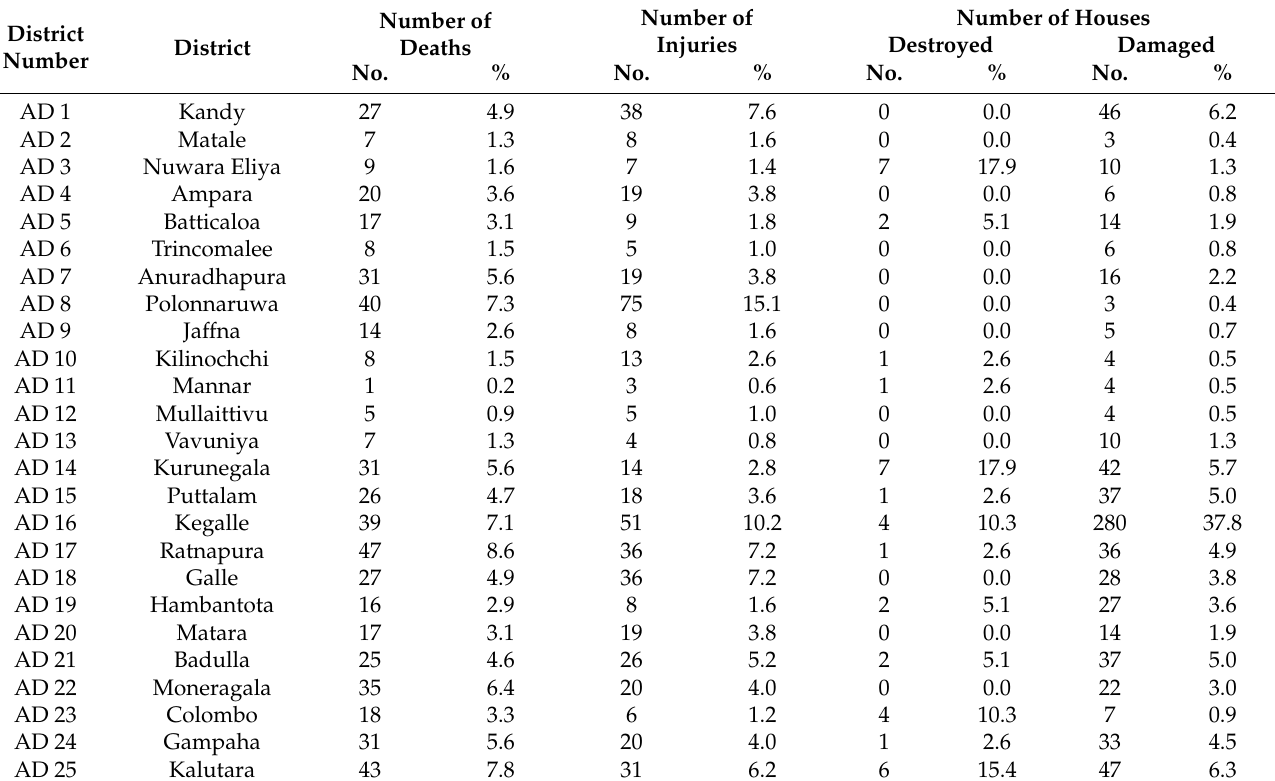
Table 3. Recorded number of lightning accidents in each administrative district, from 1974 to